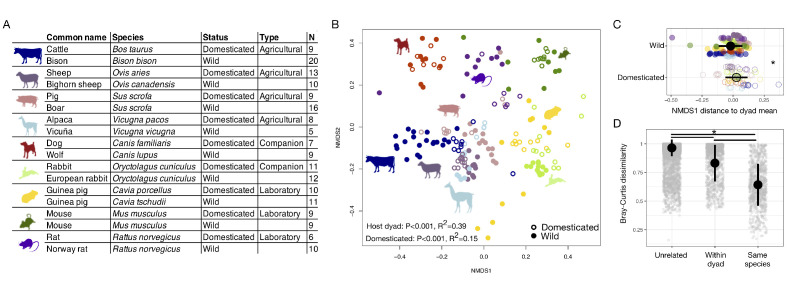
The mammalian gut microbiota carries a global signature of domestication.(A) Sampling scheme for cross-species study. (B) Nonmetric multidimensional scaling (NMDS) ordination of Bray–Curtis dissimilarities illustrates a significant signal (p<0.001, R2 = 0.15, F = 6.081, permutational MANOVA) of domestication (closed versus open circles; N = 82 domesticated and 99 wild) and clustering by host dyad (color; N = 5–20 individuals per species). (C) Distance to dyad (color) mean along Bray–Curtis ordination NMDS axis 1 differs by domestication status (p=0.006, Mann–Whitney U test). (D) Bray–Curtis dissimilarity between individuals is lowest among conspecifics, but wild–domesticated pairs also have lower dissimilarity than unrelated pairs (p<0.001, bootstrapped Mann-Whitney U tests). * indicates p<0.05. Large circles are means; bars show standard deviations.